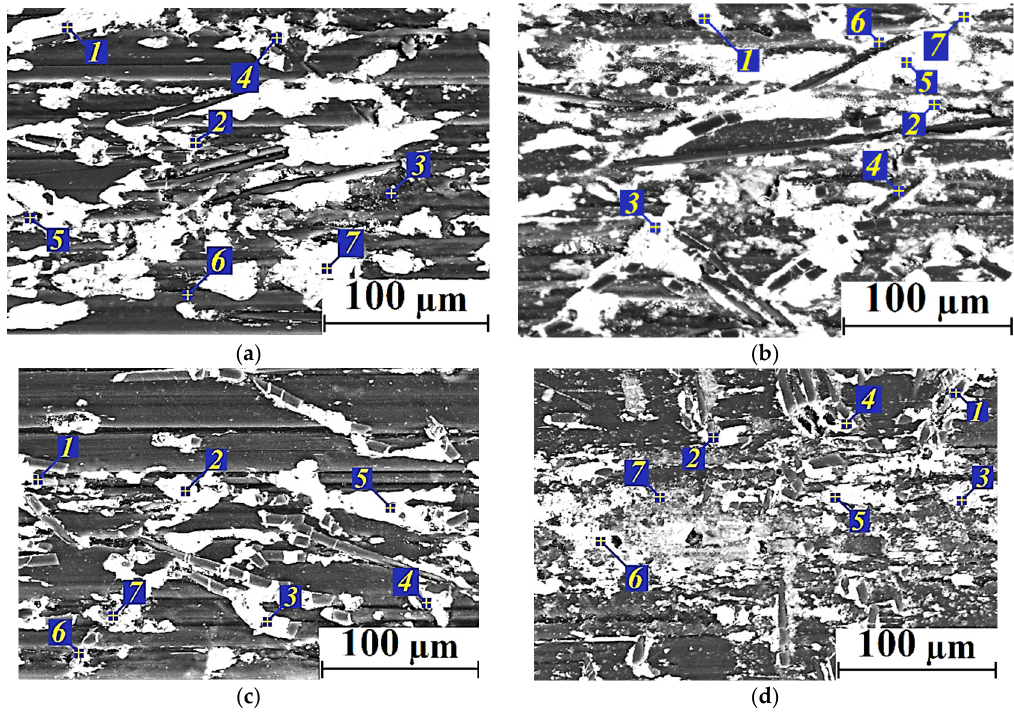
Figure 13. SEM micrographs of the wear track surfaces on the PI/10CCF/1CNT ( a ), PI/10CCF/1HNT ( b ), PEI/10CCF/1CNT ( c ) and PEI/10CCF/1HNT ( d ) nanocomposites. Digits in blue squares denote Spectra numbers in Table 6.